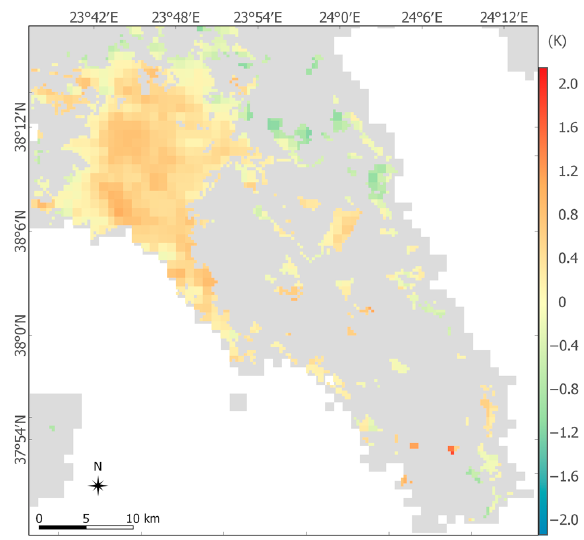
Figure 8. LST trend values (in ◦ K) of the urban pixels of Athens (Daytime).